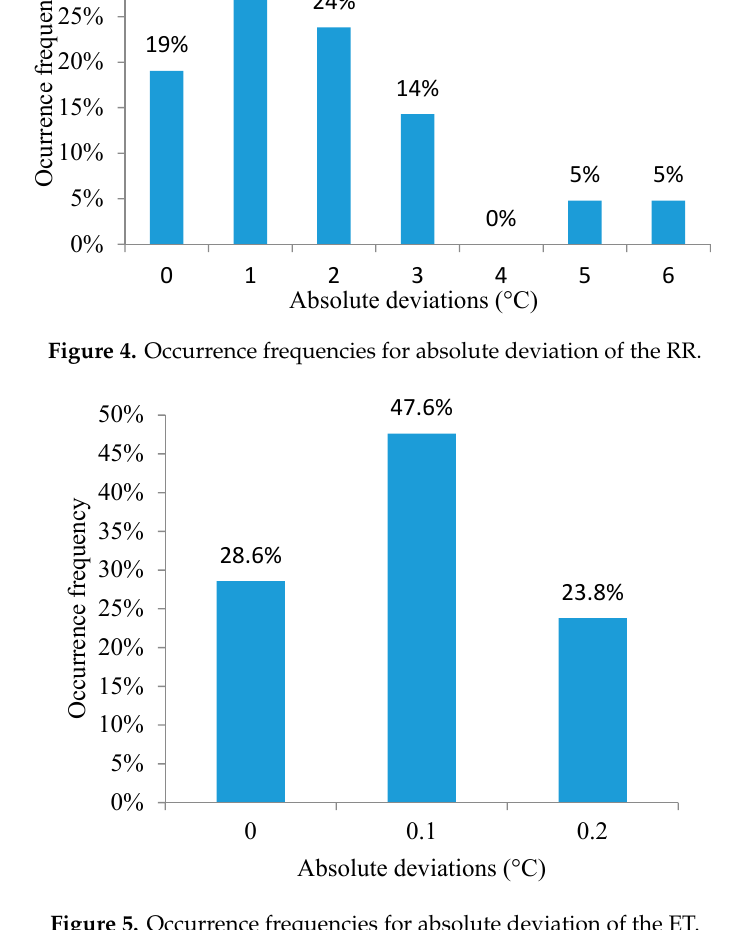
Figure 5. Occurrence frequencies for absolute deviation of the ET.